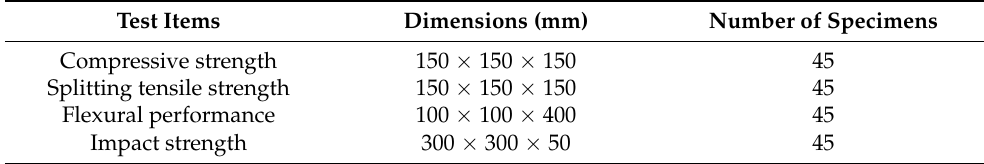
Table 5. Test items, dimensions, and numbers of